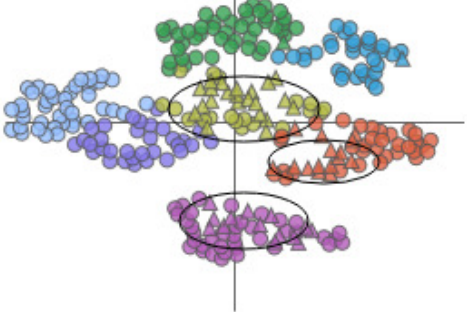
Figure 15. The AAFS Detailed Clustering View shows the distribution of selected amino acids, where the black oval marks the cavity-lining amino acids. Different colors represent different clusters. The triangles in the plot represent the mapping of cavity-lining amino acids, and the circles represent the mapping of other amino